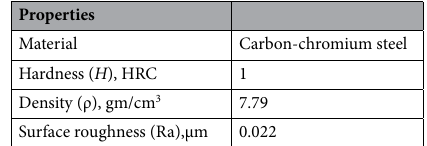
Table 3. Physical properties of the steel ball.